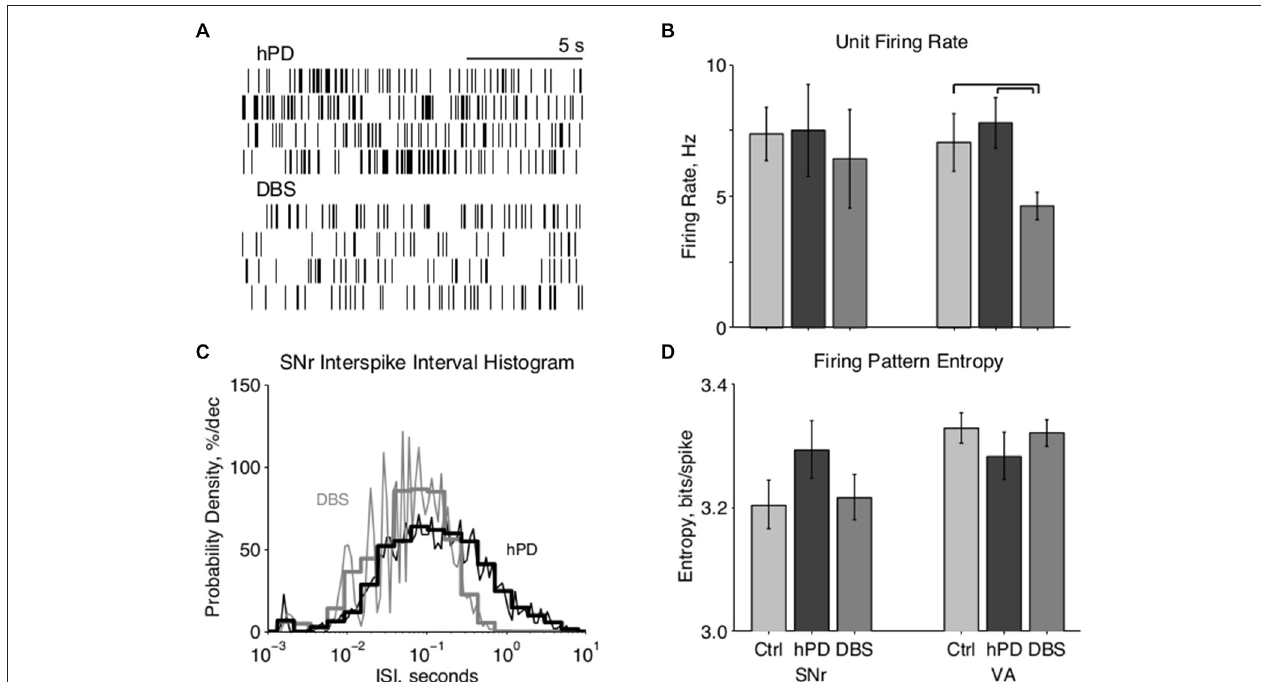
and coarse ( thick lines , five bins/decade) ISI histograms of an SNr neuron in the hPD and STN-DBS conditions. The wide distribution in the hPD case is regularized via entrainment to 100 Hz DBS, as shown by ISI peaks at 10 ms and subharmonics thereof, and a narrowing of the full distribution. (D) Population firing pattern entropy estimated from coarse (five bins/decade) ISI histograms, mean ± 50% c.i. A trend toward SNr entropy increase in the hPD condition did not reach significance with respect to either healthy ( p bca = 0.06) or STN-DBS ( p bca = 0.07)